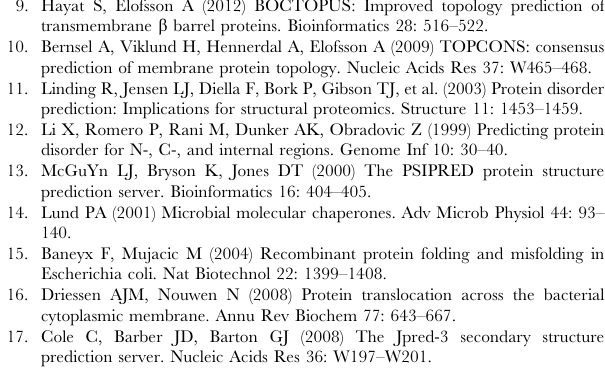
Figure S1 Partial nucleotide sequence and translation of the pCri System